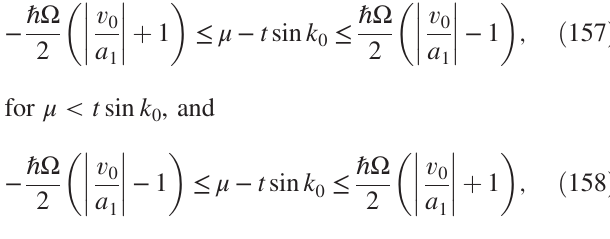
− π = 2 is k y y ¼ k 0 (cid:4) k are not canceled y ¼